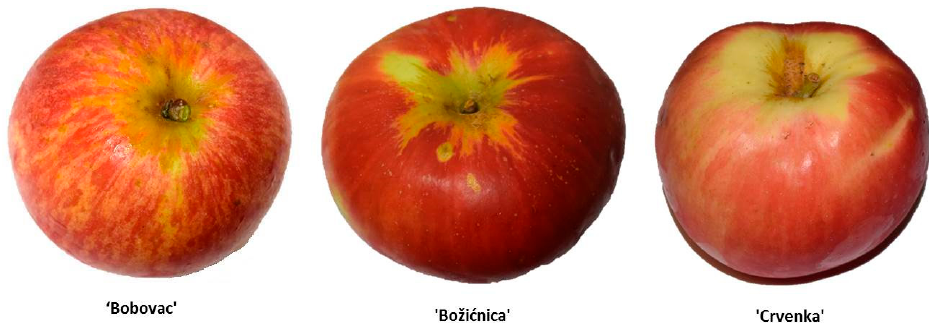
Figure 1. Fruits of the investigated apple varieties (source: Skendrovi ć Babojeli ć , 2020) .